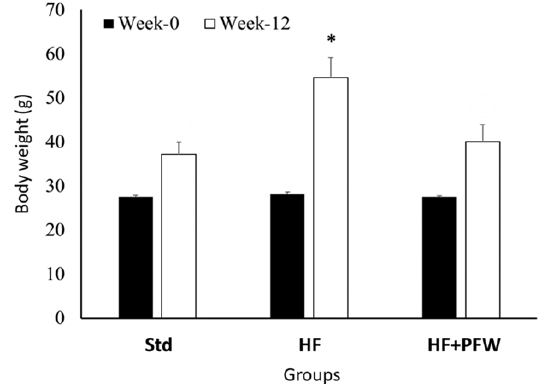
Figure 2. Effect of PFW on body weight of high-fat diet-induced mice. Mice received standard diet or high-fat diet for 12 weeks. In total, 250 mg/kg bw of PFW was orally administered once a day for 4 weeks. Data were expressed as mean ± standard error of the mean (SEM). * p < 0.05 compared with the Std group. Group Std, standard diet; group HF, high-fat diet; group HF+PFW, high-fat diet plus PFW treatment.